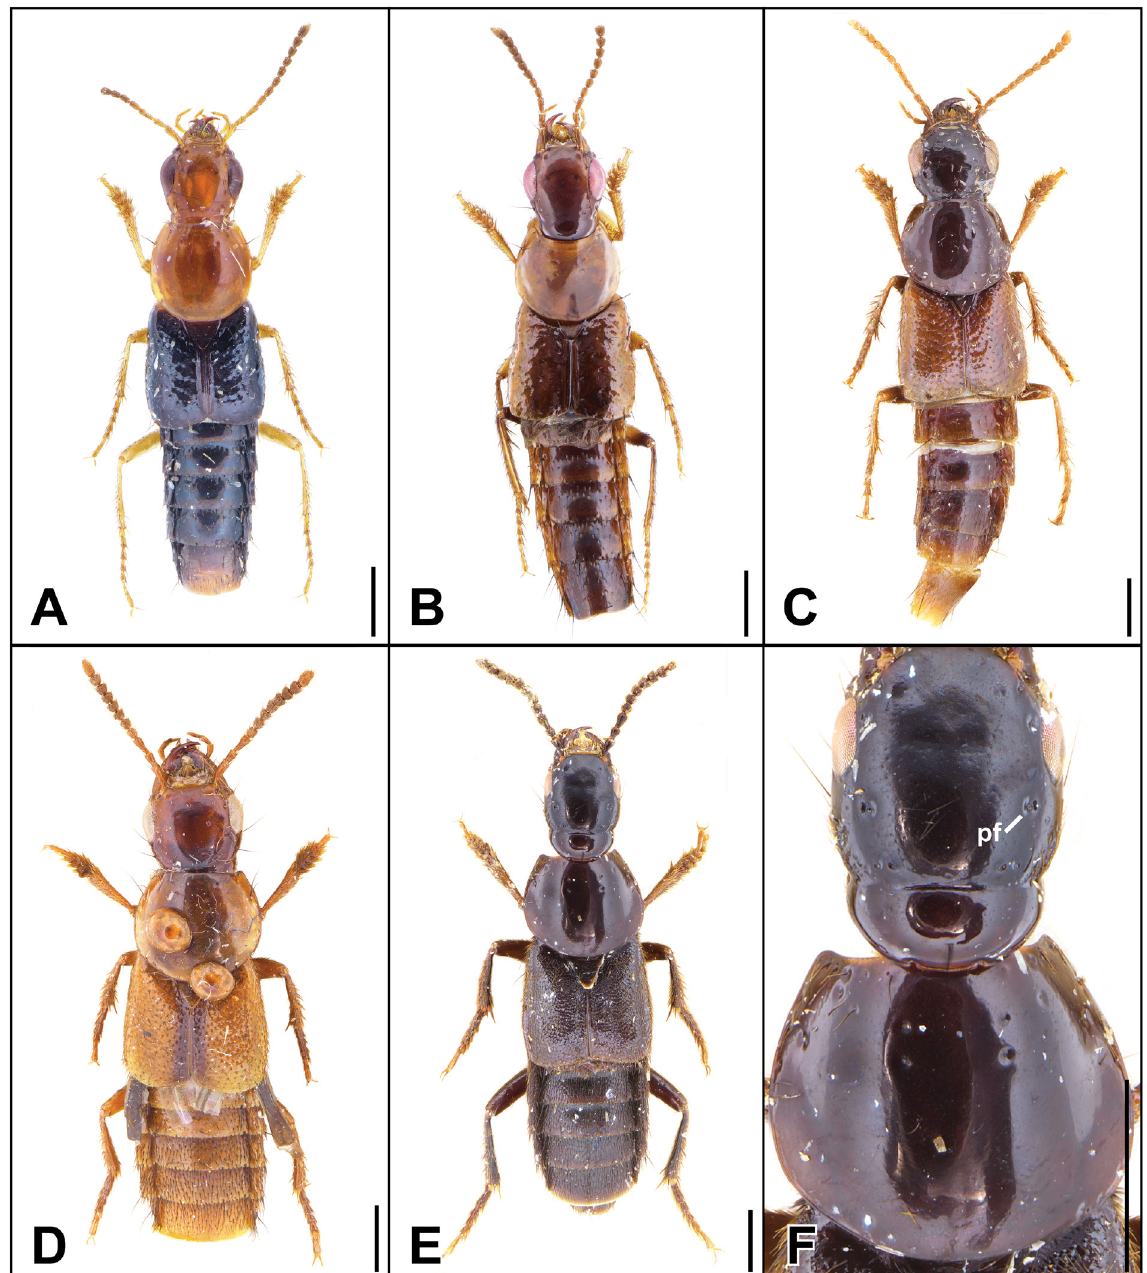
Fig. 2. A–E. Dorsal habitus. A . Malaisdius ruficeps (Scheerpeltz, 1965), ♂, paratype (NHW). B. Malaisdius smetanai gen. et. sp. nov., ♂, holotype (NME). C. Quedius ( Microsaurus ) rutilipennis Scheerpeltz, 1965, ♂, holotype (NHRS). D. Q. ( M. ) piceolineatus Scheerpeltz, 1965, ♂ holotype (NHRS). E. Q. ( M. ) impressithorax Scheerpeltz, 1965, ♀ holotype (NHRS). F. Forebody of Q. ( M. ) impressithorax Scheerpeltz, 1965. Abbreviation: Pf = posterior frontal puncture. Scale bars = 1